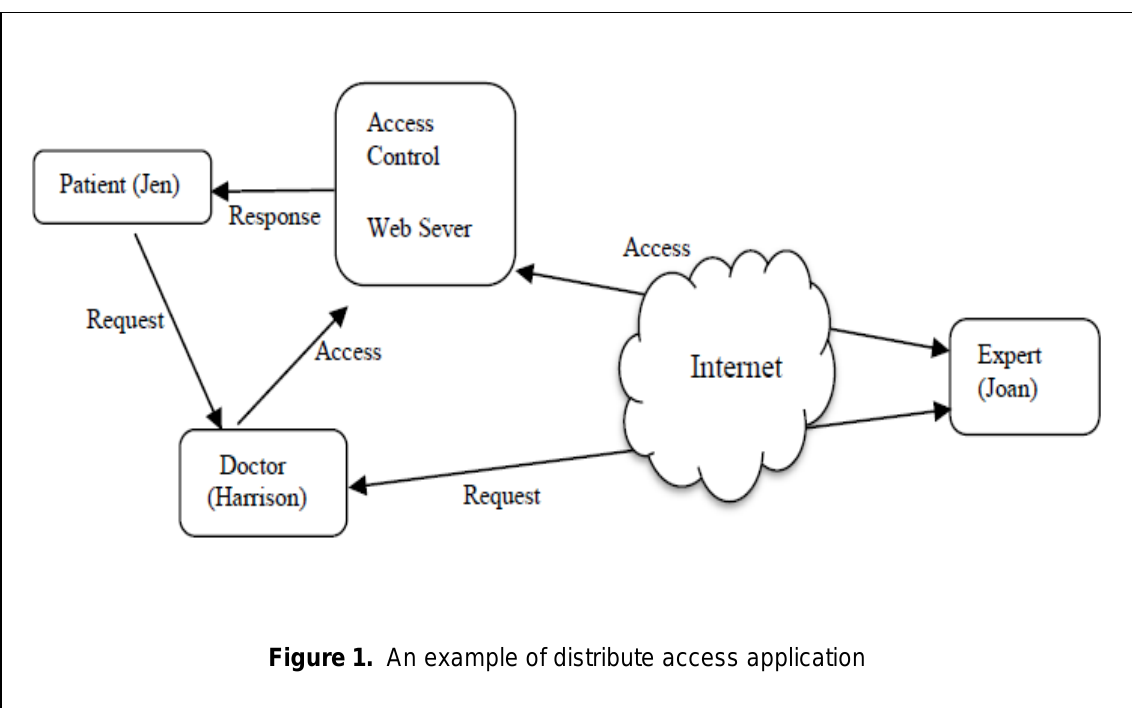
Figure 1. An example of distribute access